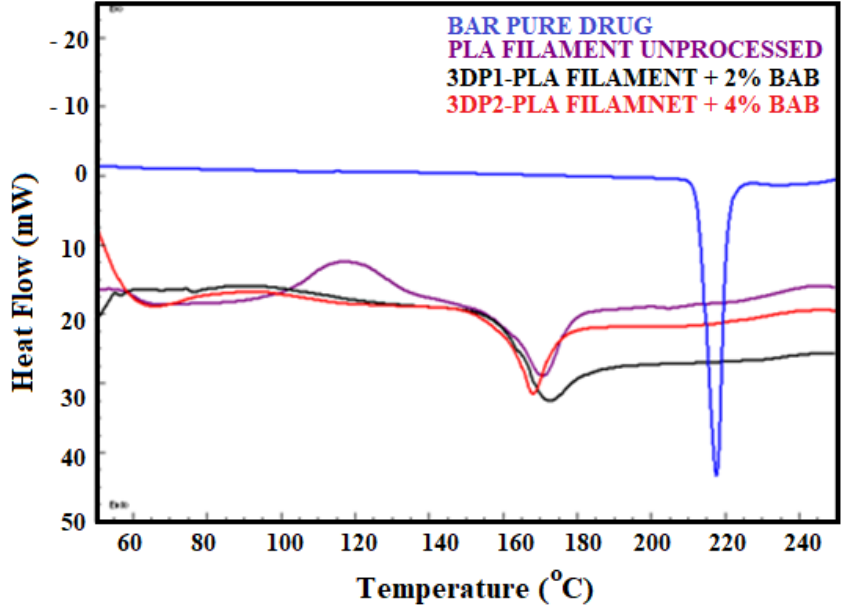
Figure 7. DSC thermograms of BAB, PLA, 3DP1, and 3DP2 pills.